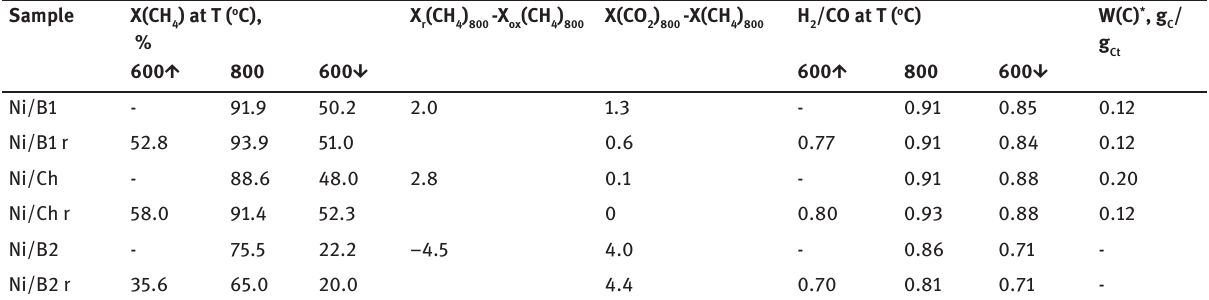
Table 5: Catalytic data for Ni/Ce-Zr-O samples. Sample